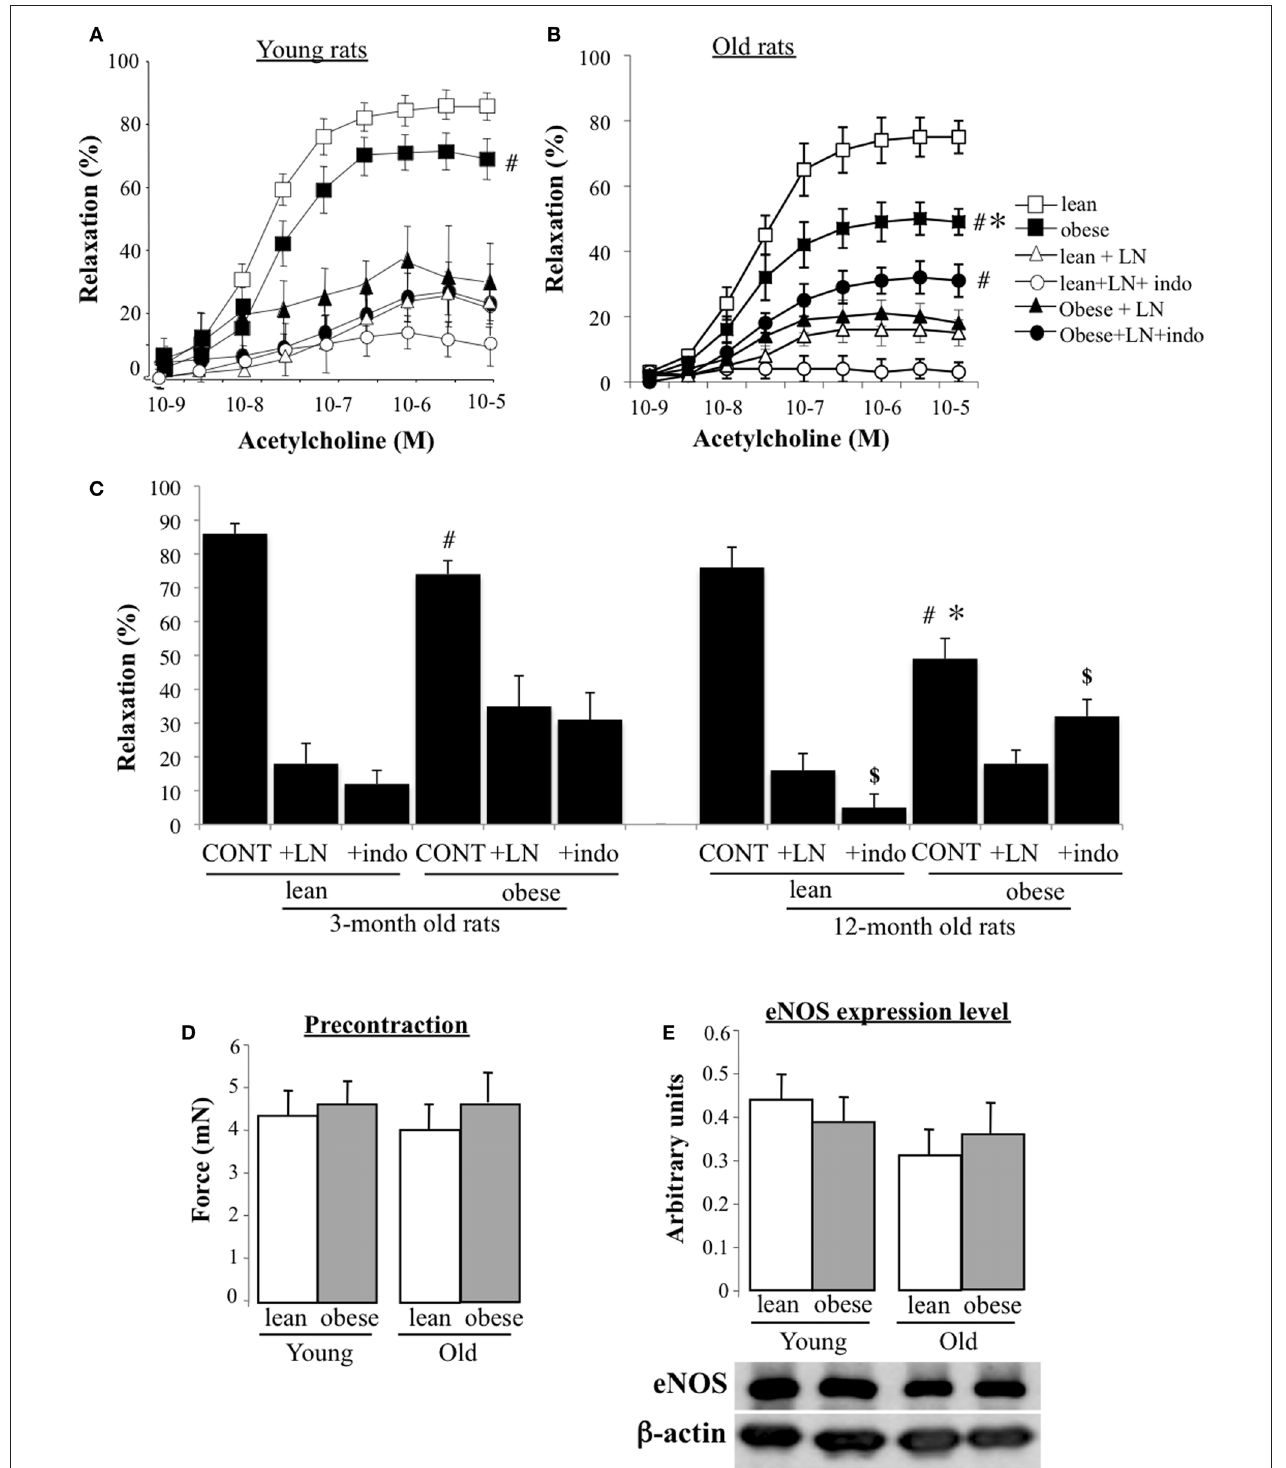
Figure 1 | Acetylcholine-mediated relaxation in mesenteric resistance arteries isolated from young (A) or old (B) lean and obese Zucker rats. Concentration–response curves to acetylcholine were repeated after incubation with L-NAME (LN) and then with L-NAME plus indomethacin (LN + indo). Bargraphs (c) represent the maximal relaxation obtained in each